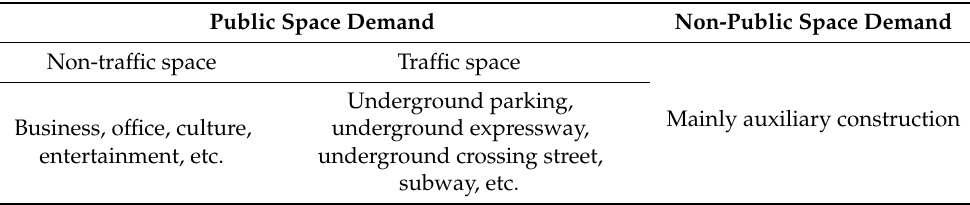
Table 8. Classification of underground space